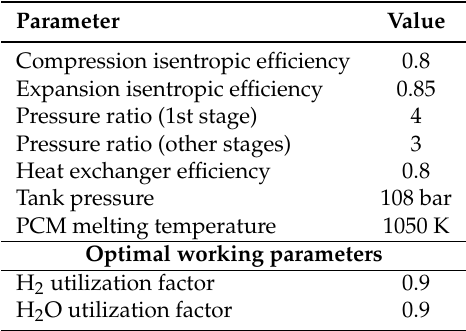
Table 2. Parameters used for the stored vapor